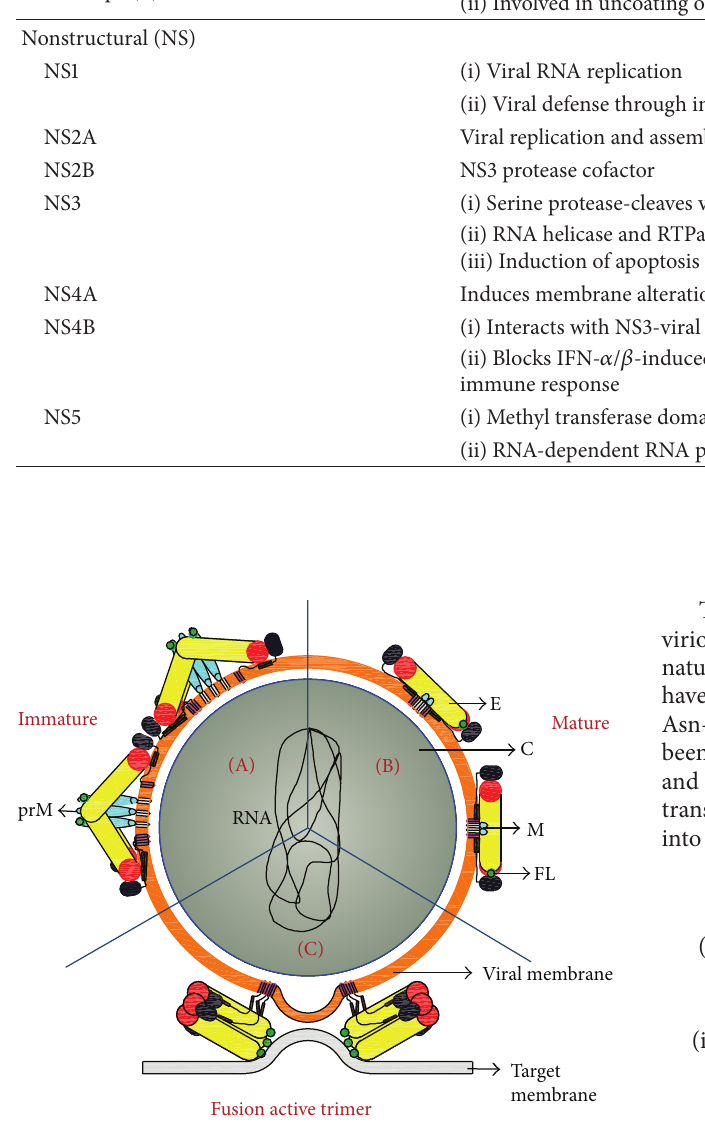
Figure 2: Organization of E protein on dengue virus surface during its life cycle. The E protein is colored as follows: EDI (red), EDII (yellow), EDIII (blue), and the FL (green). prM and M protein are colored as cyan. (a) Immature virus contains 60 trimeric spikes of E and prM heterodimer. (b) Mature virus contains 90 homodimers of E protein. (c) These homodimers then further undergo reorganization to form fusion active E homotrimers in which fusion loop is exposed. M protein is not shown in the fusion trimer for simplicity. E, C, M, FL, and prM denote envelope, capsid, membrane, fusion loop, and precursor membrane,